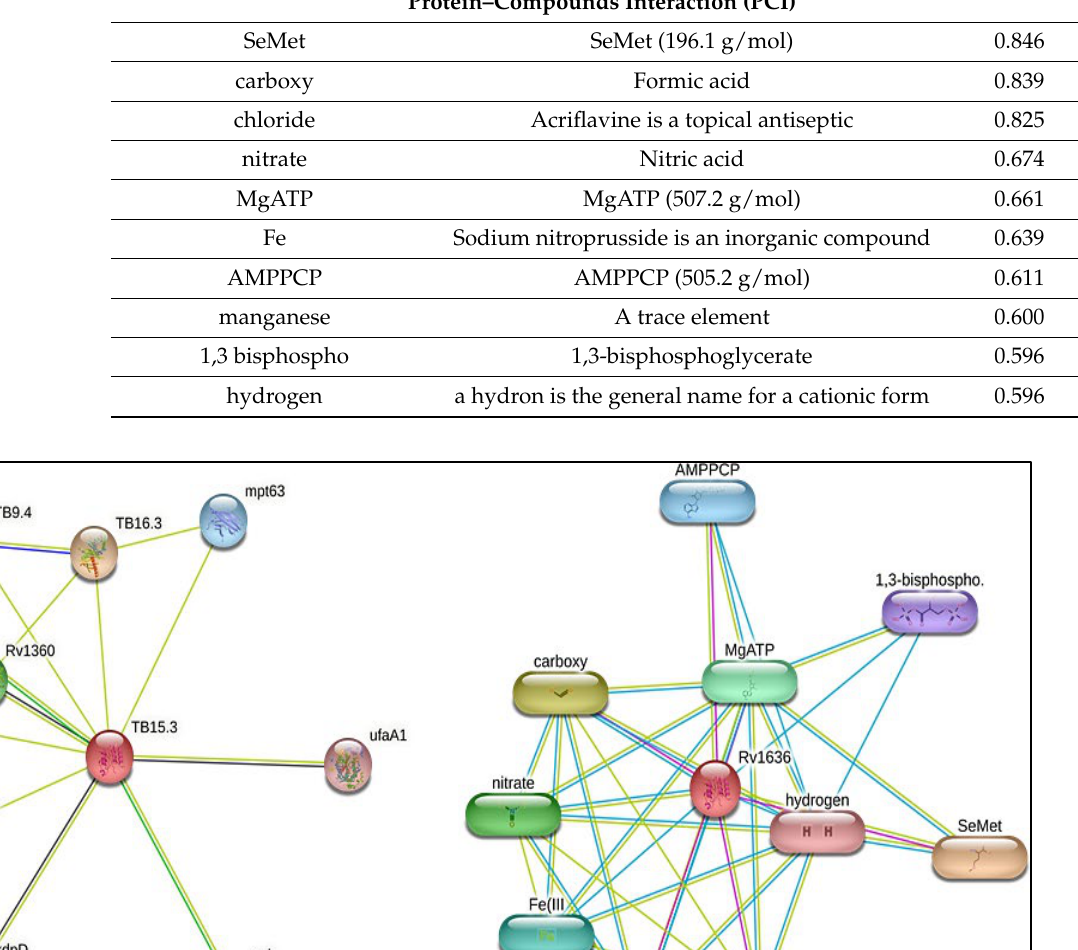
Table 5. Docking hits and their binding affinities toward Rv1636 protein.